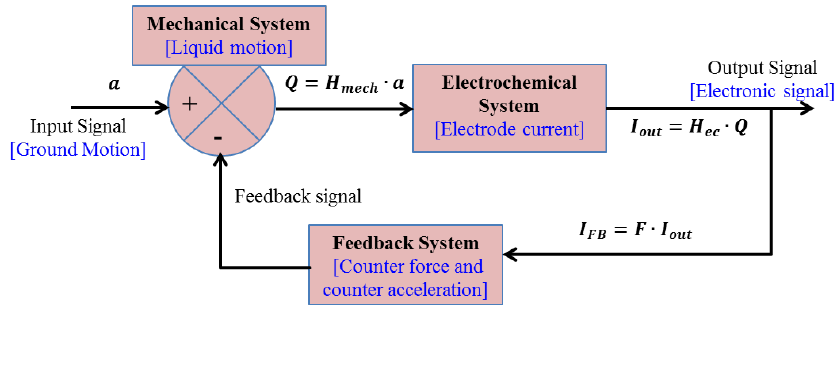
Figure 2. A block diagram of MET motion sensor including feedback